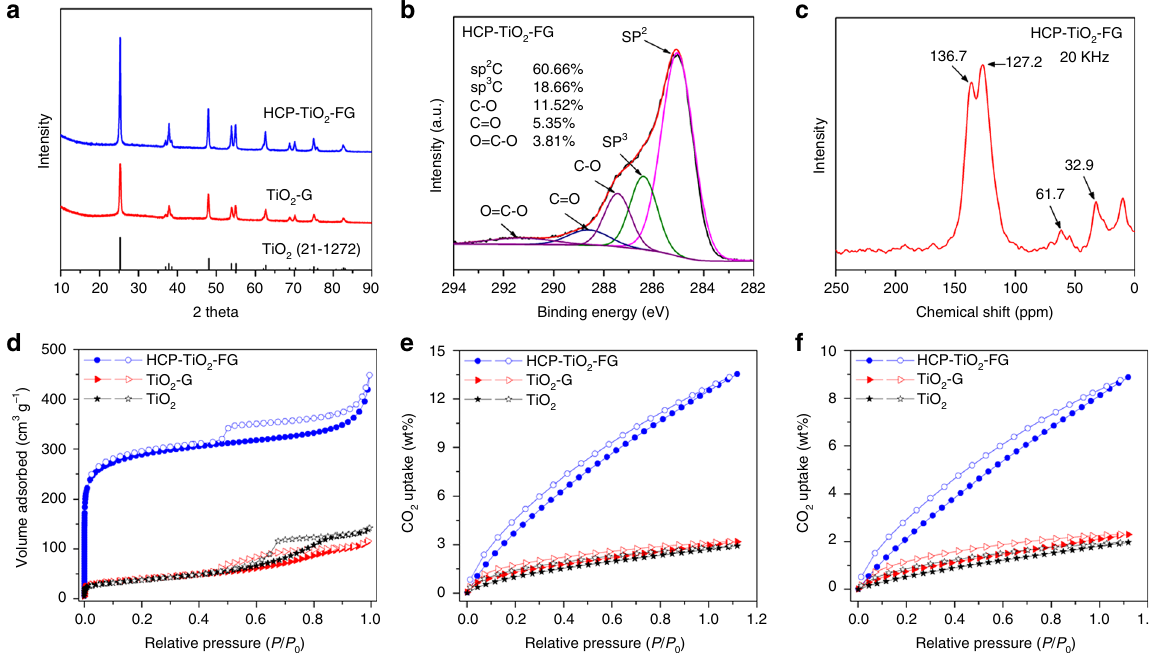
Fig. 3 Chemical structure, porosity, and CO 2 uptake of various photocatalysts. a XRD image of TiO 2 , TiO 2 -G, and HCP-TiO 2 -FG. b C 1s pro fi les of HCP- TiO 2 -FG. c 13 C cross-polarization/magic-angle spinning (CP/MAS) NMR spectra of HCP-TiO 2 -FG. d Nitrogen adsorption and desorption isotherms at 77.3 K of samples. e Volumetric CO 2 adsorption isotherms and desorption isotherms up to 1.00 bar at 273.15 K of samples. f Volumetric CO 2 adsorption isotherms and desorption isotherms up to 1.00 bar at 298.15 K of